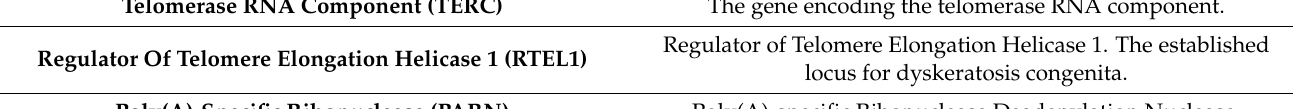
Table 1. Telomere-related genes in IPF. The coding gene for the telomerase reverse transcriptase. It is responsible for 15% of familial pulmonary fibrosis (FPF). There are gender differences in this mutation, with females being 11.9 years older at diagnosis than males. The gene encoding the telomerase RNA component. Regulator of Telomere Elongation Helicase 1. The established locus for dyskeratosis